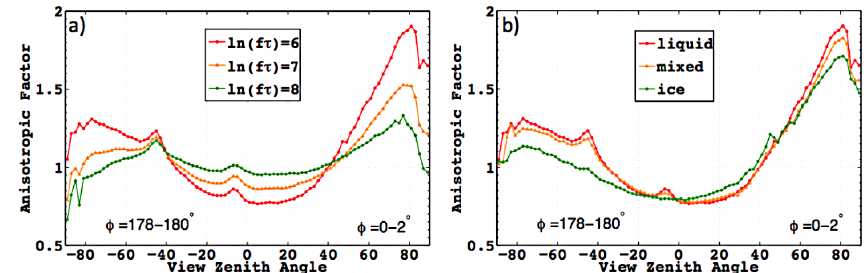
Figure 5. CERES SW anisotropic factors over ocean in the principal plane for (a) liquid clouds with different ln (f e τ) values, (b) clouds of different phases with ln (f e τ) = 6. Anisotropic factors are derived for θ 0 = 44–46 ◦ based upon 60 months of CERES Terra measurements.